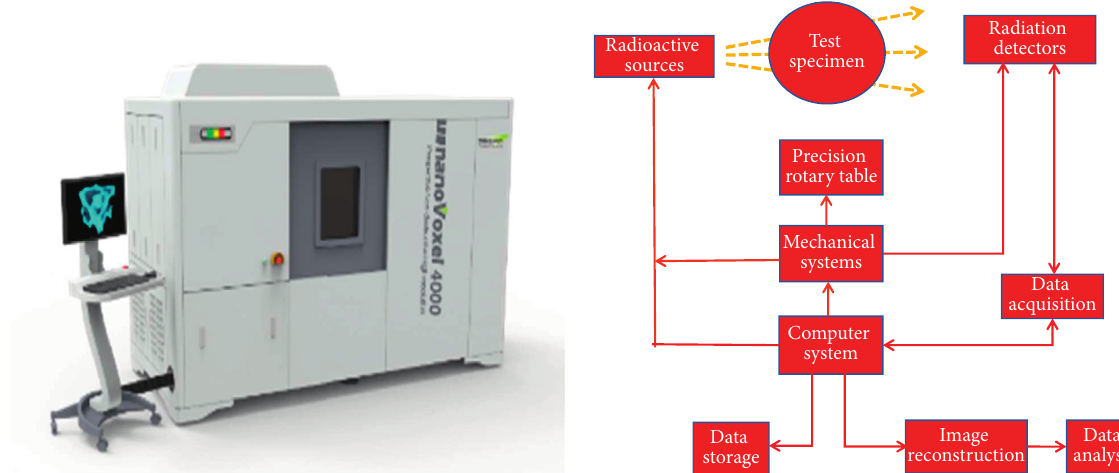
Figure 2: High-resolution CT scan test system [22].